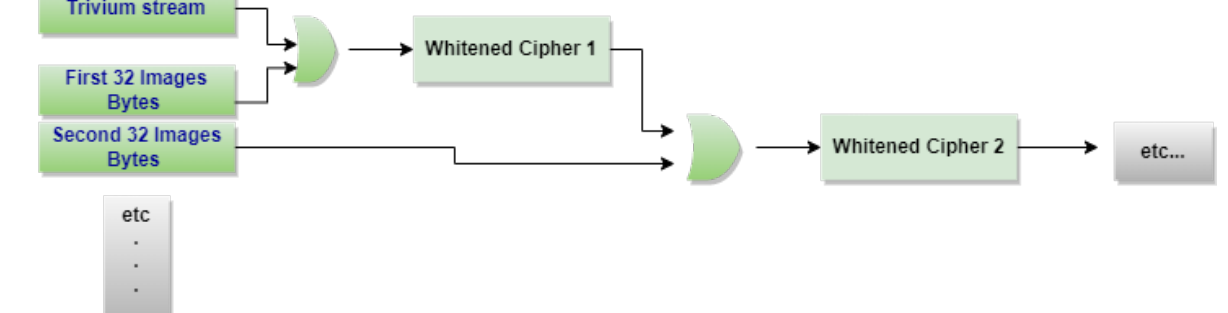
Figure 6. Image masking